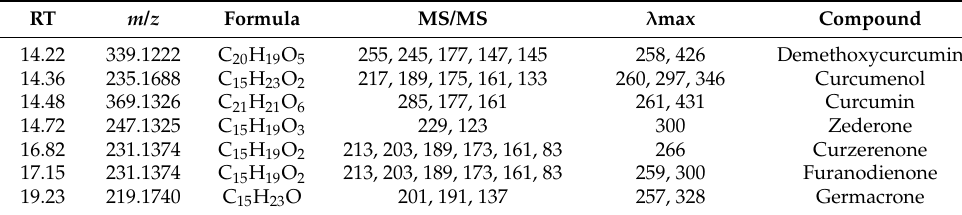
Figure 2. The UHPLC-HRMS analyses of C. phaeocaulis extract. ( A ) UHPLC-PDA chromatogram of the extract. The high-resolution mass spectra of seven main peaks ( B ) and the standard compounds ( C ) are shown. Table 1. Identification of seven compounds from C. phaeocaulis extract.